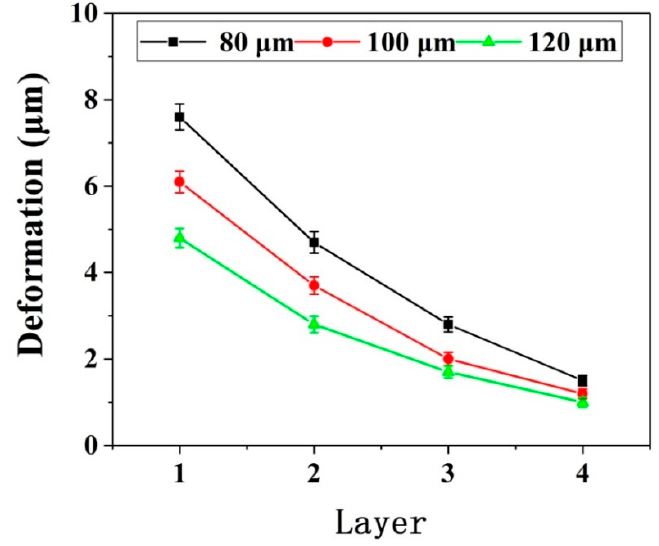
Figure 8. Thin wall deformation.